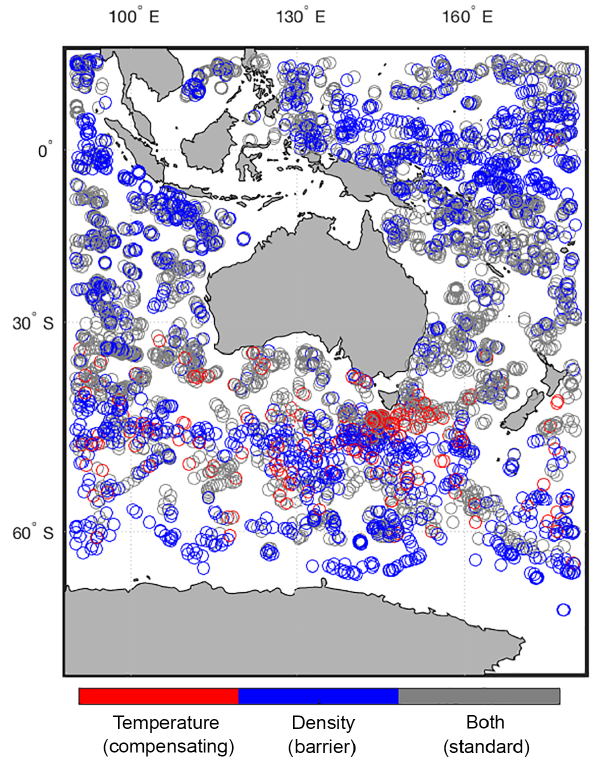
Figure 1. Criteria used to identify the MLD for each Argo observa- tion. Use of the density criterion implies the existence of a barrier layer, while use of the temperature criterion implies the existence of a compensated